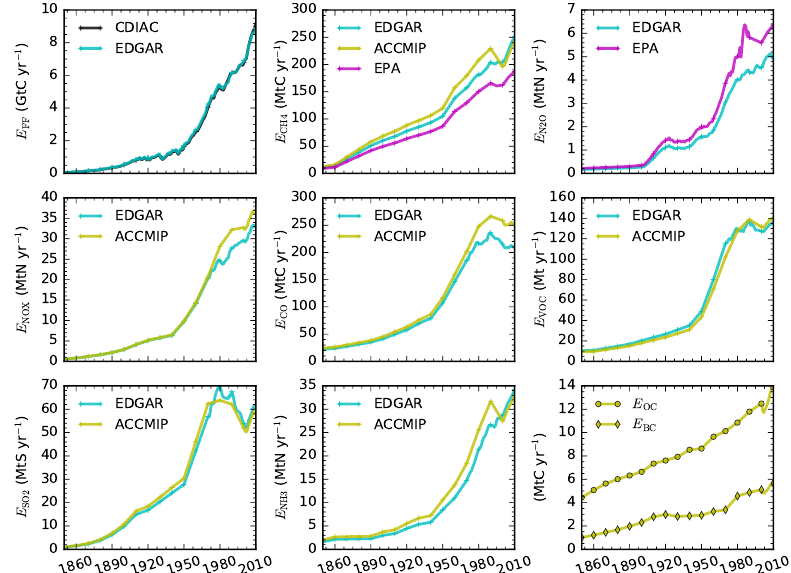
Figure 2. Time series of the main anthropogenic emissions used as potential inputs of OSCAR (Sect. 2.2.1). Other drivers of the model, i.e., emissions of halogenated compounds and LULCC, are shown in Figs. S1 and S2, respectively.